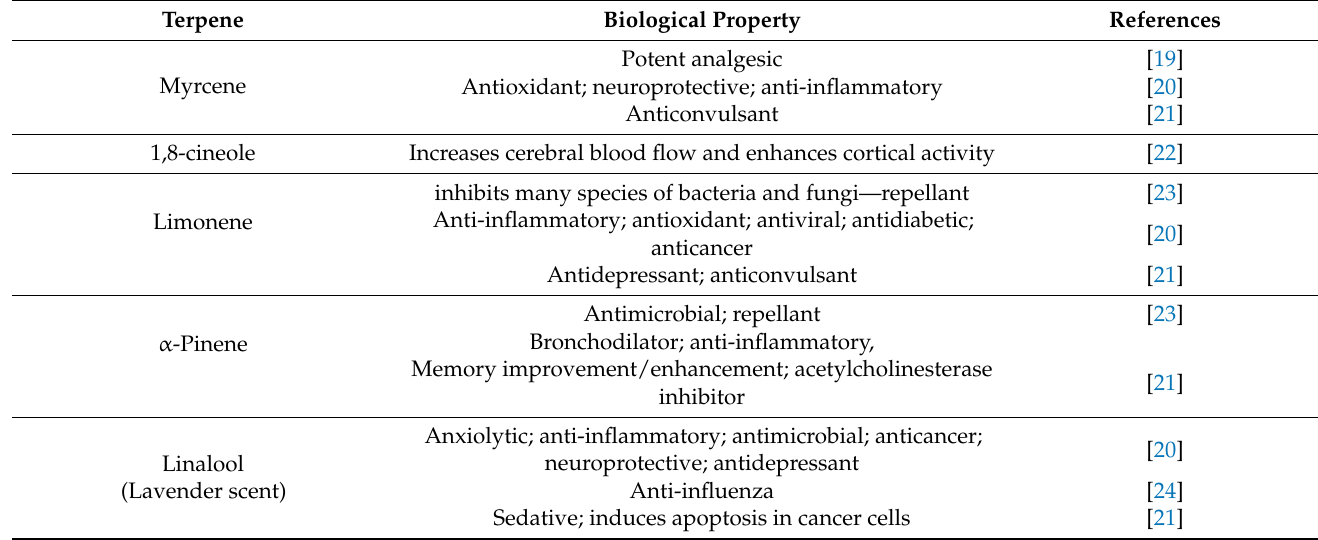
Table 3. The biological properties of some common terpenes in